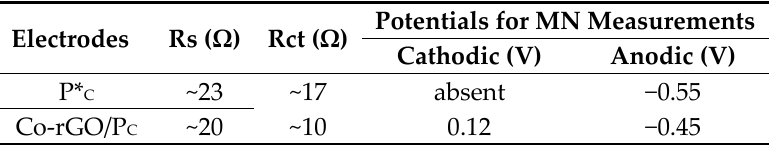
Table 1. Measured electrochemical